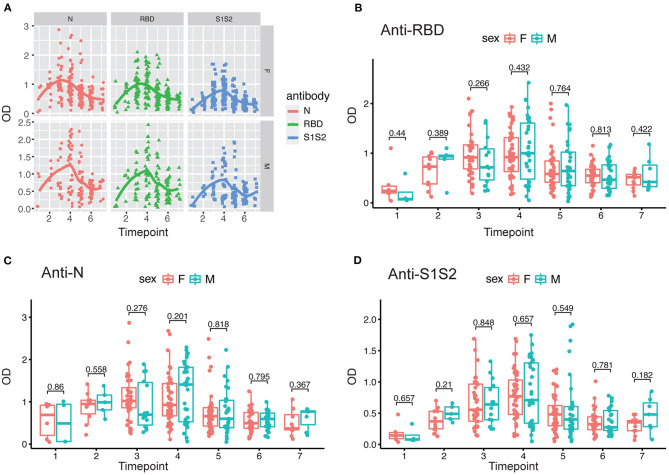
Evaluation of antibody response between female and male patients. (A) Response of antibodies (anti-N, anti-RBD, and anti-S1S2) between female and male patients. (B–D) Comparison of anti-RBD (B), anti-N (C), and anti-S2S2 (D) antibody responses between female (“F”) and male (“M”) patients. Time points 1–7 represent days 1–7, 8–14, 15–28, 29–56, 57–84, 85–112, and >112, respectively, after symptom onset. P-values were calculated by Student's t-test, and p-values < 0.05 were considered significant.